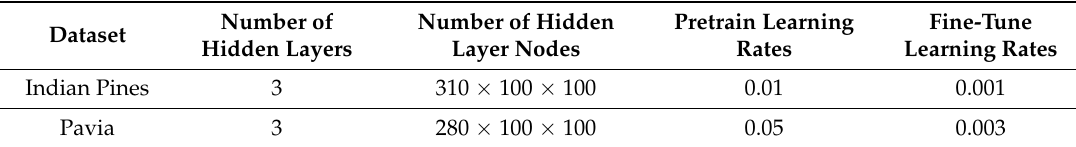
Table 3. The deep belief network (DBN) network